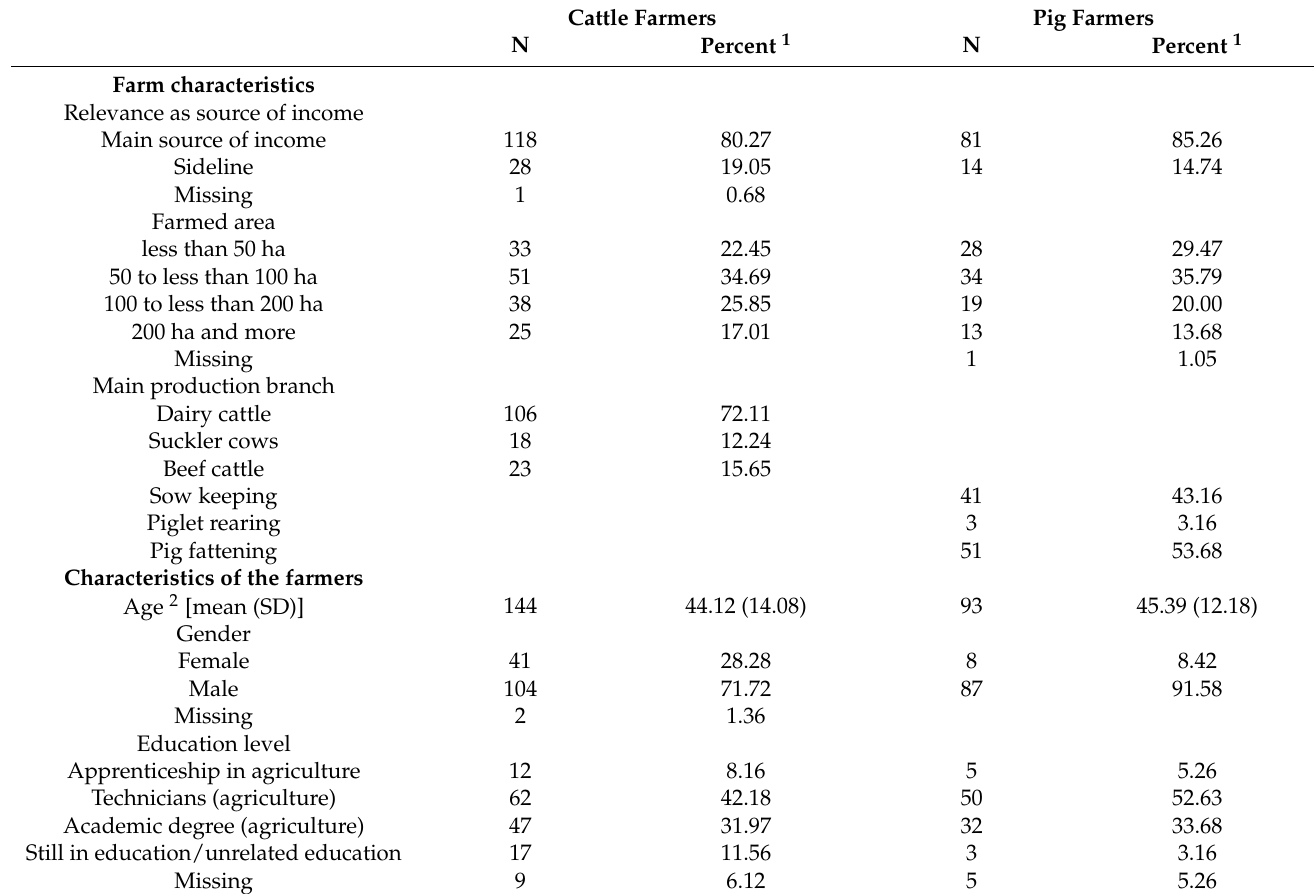
Table 2. Characteristics of the farms and sociodemographic data of the farmers, separately for cattle farmers (N = 147) and pig farmers (N = 95). Cattle